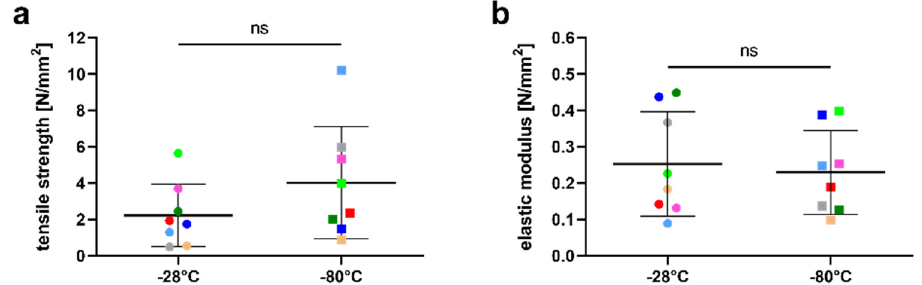
Figure 3. Tensile strength ( a ) and elastic modulus ( b ) after storage at -28 °C and -80 °C, respectively. Horizontal bars show mean values ± standard deviation. Pairs from the same donor are shown in matching colors. ns: Not statistically significant.